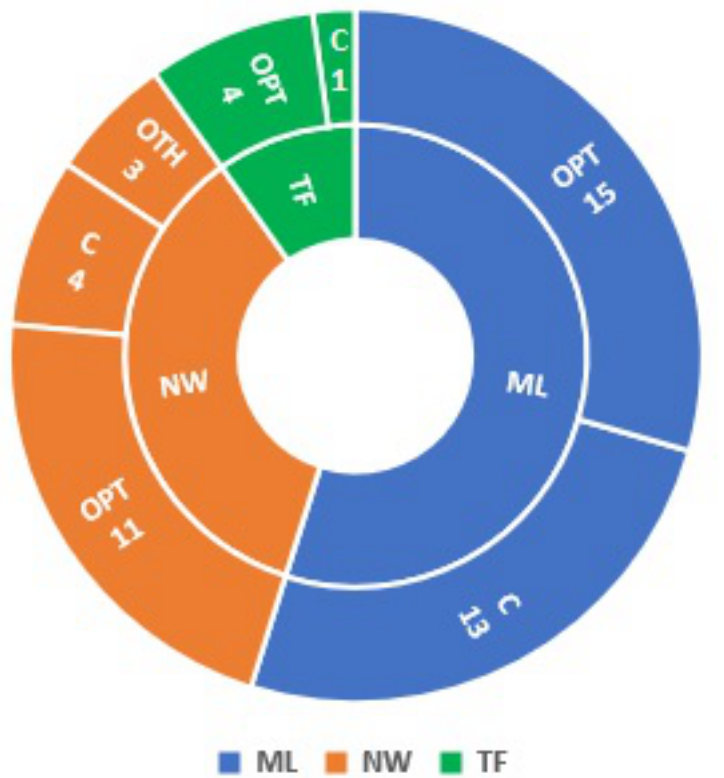
Figure 4. The distribution of the analyzed studies categorized by scope (inner circle) and main price definition method (outer circle). Labels: ML = Managed Lanes, NW = Networks, TF = Tolled Facilities, OPT = Optimization, C = Control, OTH = Other.